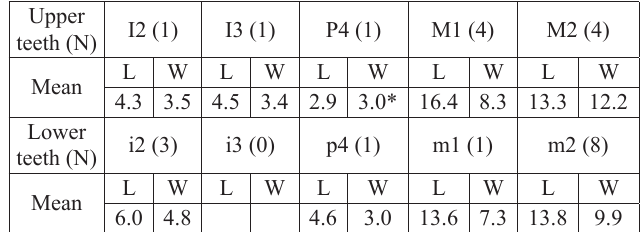
Table 2. Average tooth measurements (in mm) of Sphenopsalis . Abbre- viations: L, mesiodistal length; N, number of specimens; W, buccolin- gual width; the asterisk indicates estimation from tooth alveolus. The actual measurements for each tooth are provided in the SOM